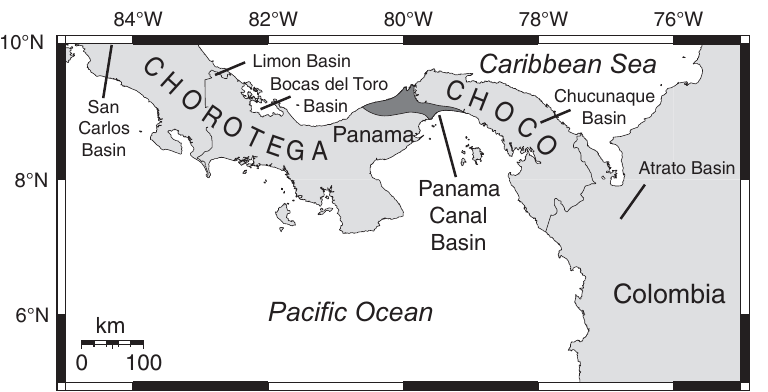
Figure 1. Location of the Panama Canal Basin and other depositional basins in southern Central America.